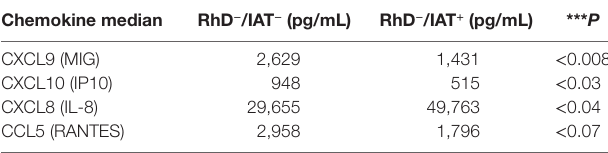
TaBle 2 | Chemokines according to maternal RhD